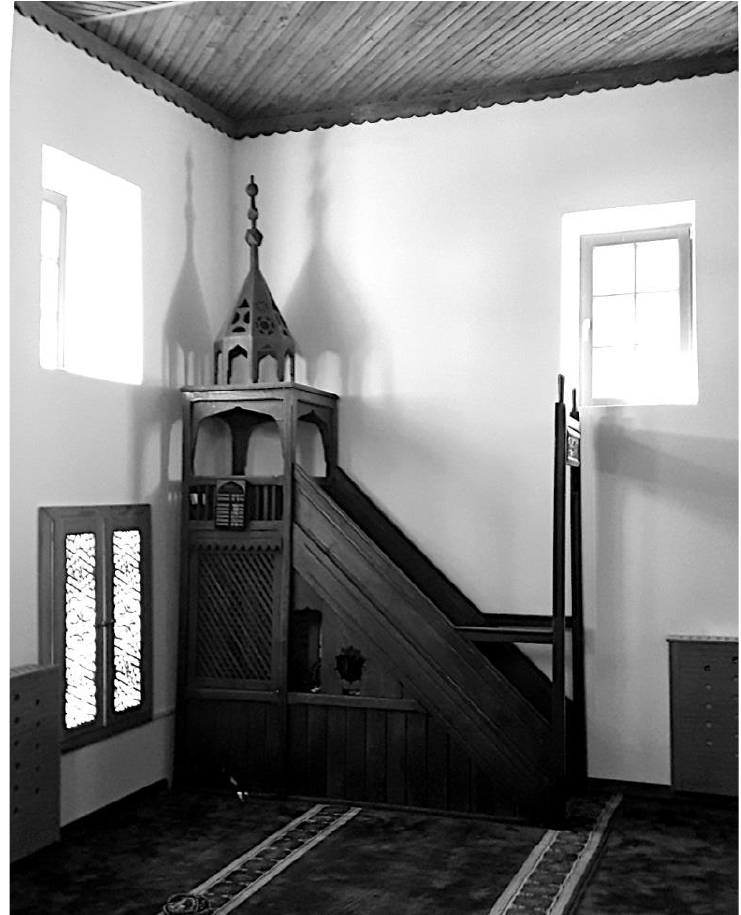
Figure 6. Interior of the mosque after the renovation showing minber (Photo by the author)